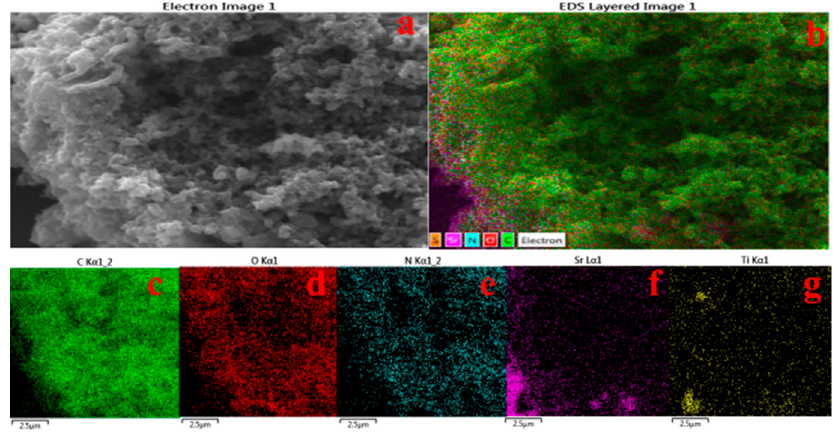
Figure 3. ( a ) FESEM image and ( b ) EDX elemental mapping of the P-Sr500 nanocomposite on a Si wafer for the following elements: ( c ) C, ( d ) O, ( e ) N, ( f ) Sr and ( g ) Ti.